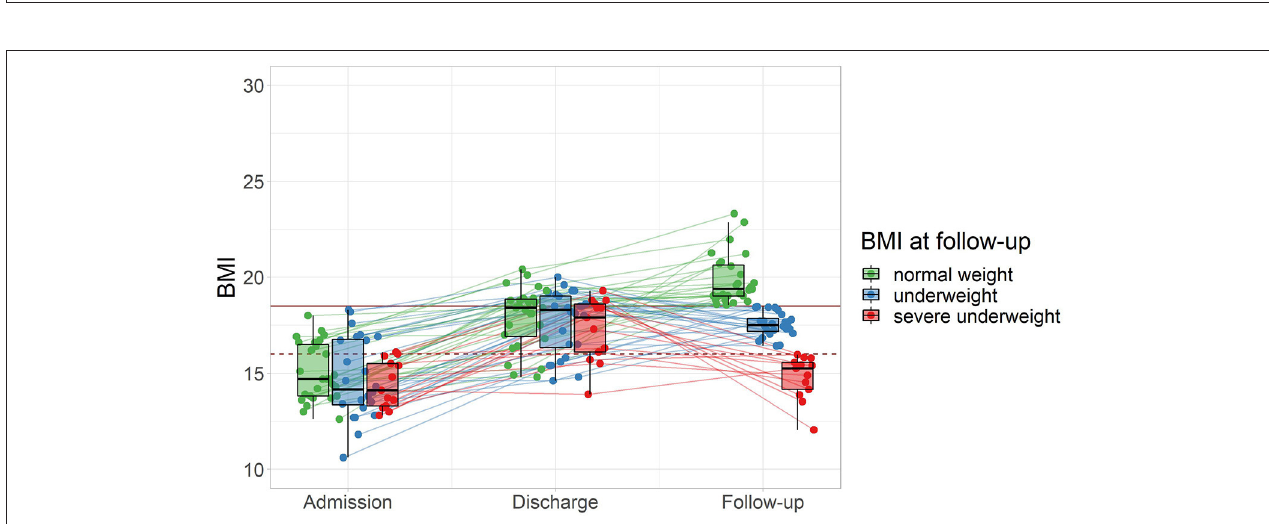
FIGURE 2 | Follow-up outcome and weight trajectories of patients from admission to follow-up ( n = 63) grouped by BMI at follow-up. The horizontal mark of the boxplots signifies the median, edges of the box represent 25 and 75th percentiles, and the whiskers extend to 1.5 interquartile ranges. Normal weight: BMI ≥ 18.5 kg/m 2 , represented by the solid horizontal line, severe underweight: BMI < 16.0 kg/m 2 , represented by the dashed horizontal